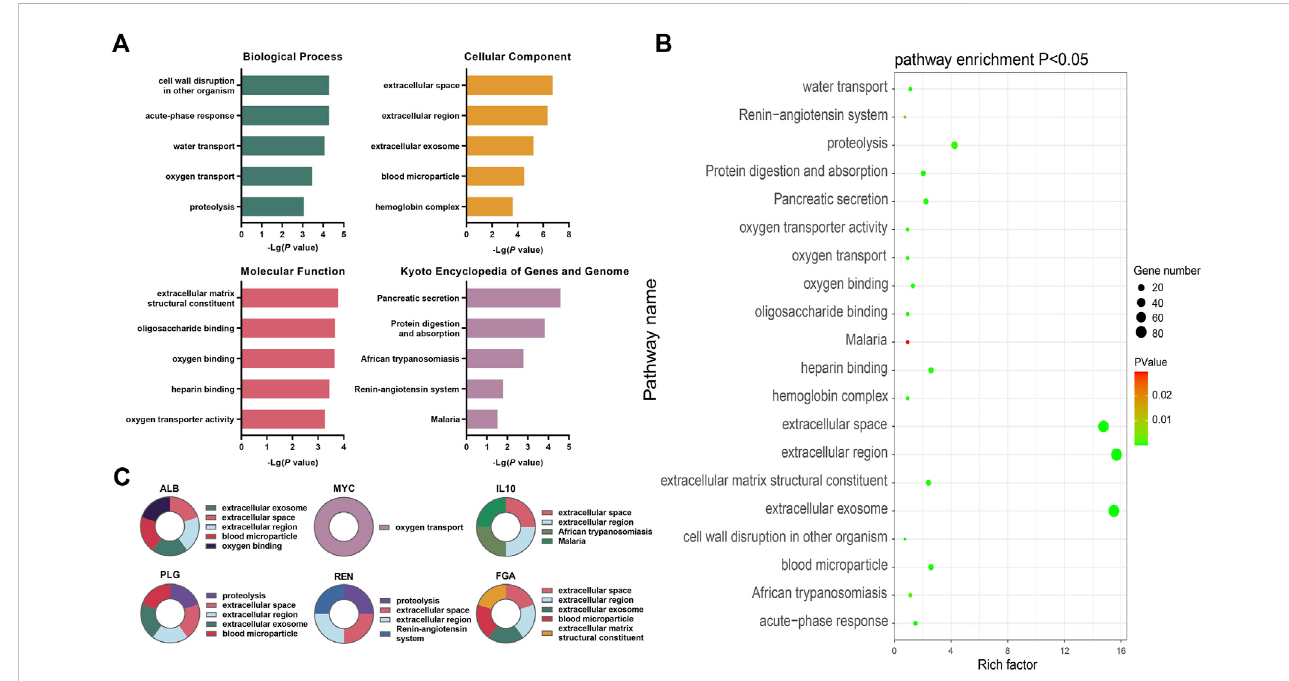
FIGURE 6 Bioinformatics analysis of key differentially expressed genes during the occurrence and development of CKD (A) The top fi ve annotations in biological process,cellcomposition,molecularfunction,andKEGGpathwayenrichmentanalysisofDEGsbetweenthecontrolgroupandtheHUAwithCKDsubgroups; (B) Screening the top 10 CKD differential genes of PPI network degree value, combining with go functional annotation and KEGG pathway analysis, it was found that the key DEGs for the occurrence and development of CKD might be ALB, MYC, IL10, PLG, REN and FGA , and mapping the function and regulatory signal pathway of genes; (C) The bubble diagram of enrichment analysis between the control group and the HUA combined CKD subgroup shows that the larger the bubble, the more genes enriched in this functional pathway, and the closer the color of the bubble to green, indicating the greater signi fi